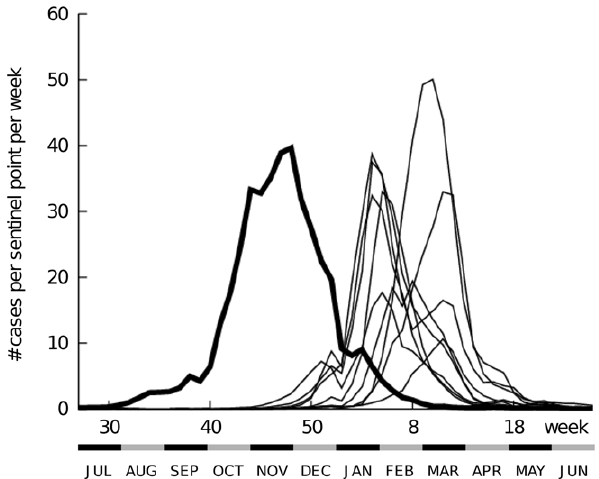
Figure 1. Historical view of reported cases of influenza-like illness in Japan by week of illness onset. The horizontal axis shows the year by week, beginning with the 27 th week of one year and going through the 26 th week of the next. The solid bold line indicates the number of cases per week at sentinel points in 2009. Data from cases of seasonal influenza in other years are indicated by thin